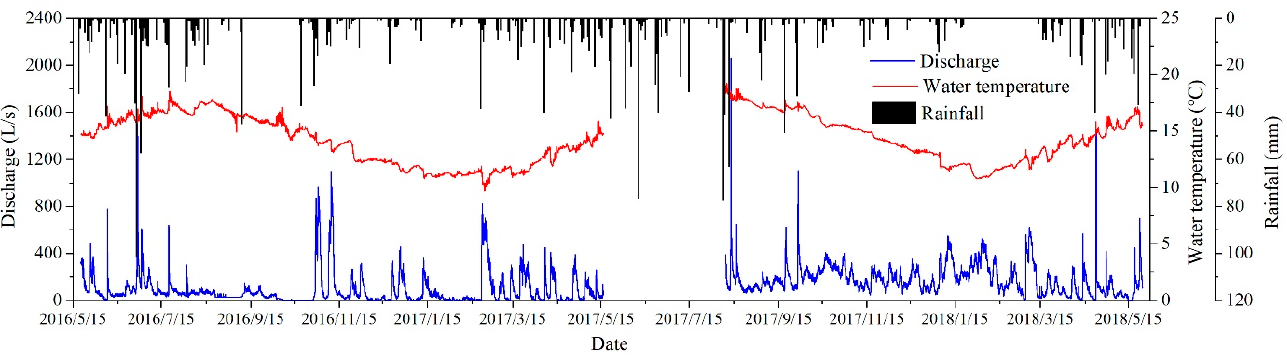
Figure 3. Precipitation–discharge–water-temperature response of Daiye cave